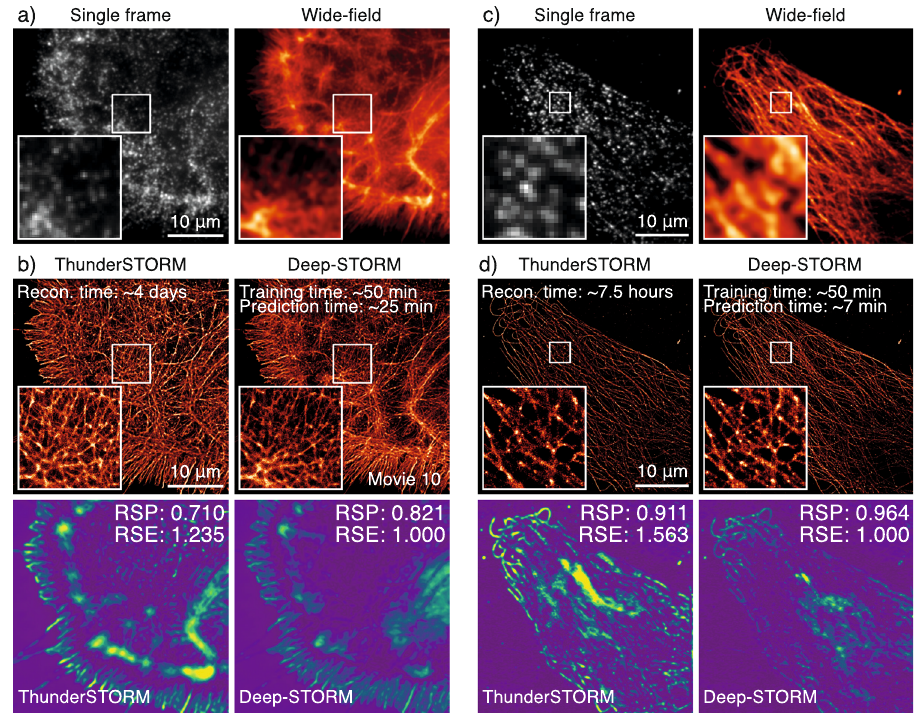
Fig. 5 Super-resolution microscopy network (Deep-STORM). Example of data that can be generated using the ZeroCostDL4Mic Deep-STORM notebook. a Single frame of the raw BIN10 dataset, phalloidin labelling of a glial cell, and the wide- fi eld image. b Top: Comparison of ThunderSTORM 51 Multi-Emitter Maximum likelihood estimation (ME-MLE) and Deep-STORM reconstructions (see also Supplementary Movie 10). ME-MLE processing times were estimated using an Intel Core i7-8700 CPU @ 3.2 GHz, 64GB RAM machine. Bottom: SQUIRREL 52 analysis comparing reconstructions from ThunderSTORM ME-MLE and Deep-STORM, highlighting better linearity of the reconstruction with respect to the equivalent wide- fi eld dataset for Deep- STORM. c Single frame of the raw of a DNA-PAINT 50 dataset of a U2OS cell immuno-labelled for tubulin and the wide- fi eld image. d Top: Comparison of ThunderSTORM 51 Multi-Emitter Maximum likelihood estimation (ME-MLE) and Deep-STORM reconstructions. ME-MLE processing times were estimated using an Intel Core i7-8700 CPU @ 3.2 GHz, 32 GB RAM. Bottom: SQUIRREL 52 analysis comparing reconstructions of ThunderSTORM ME-MLE and Deep- STORM, highlighting better linearity of the reconstruction with respect to the equivalent wide- fi eld dataset for Deep-STORM. The reconstruction times shown for Deep-STORM were obtained with the NVIDIA Tesla P100 PCIe 16 GB RAM available on Google Colab. RSP resolution -scaled Pearson coef fi cient, RSE root-squared